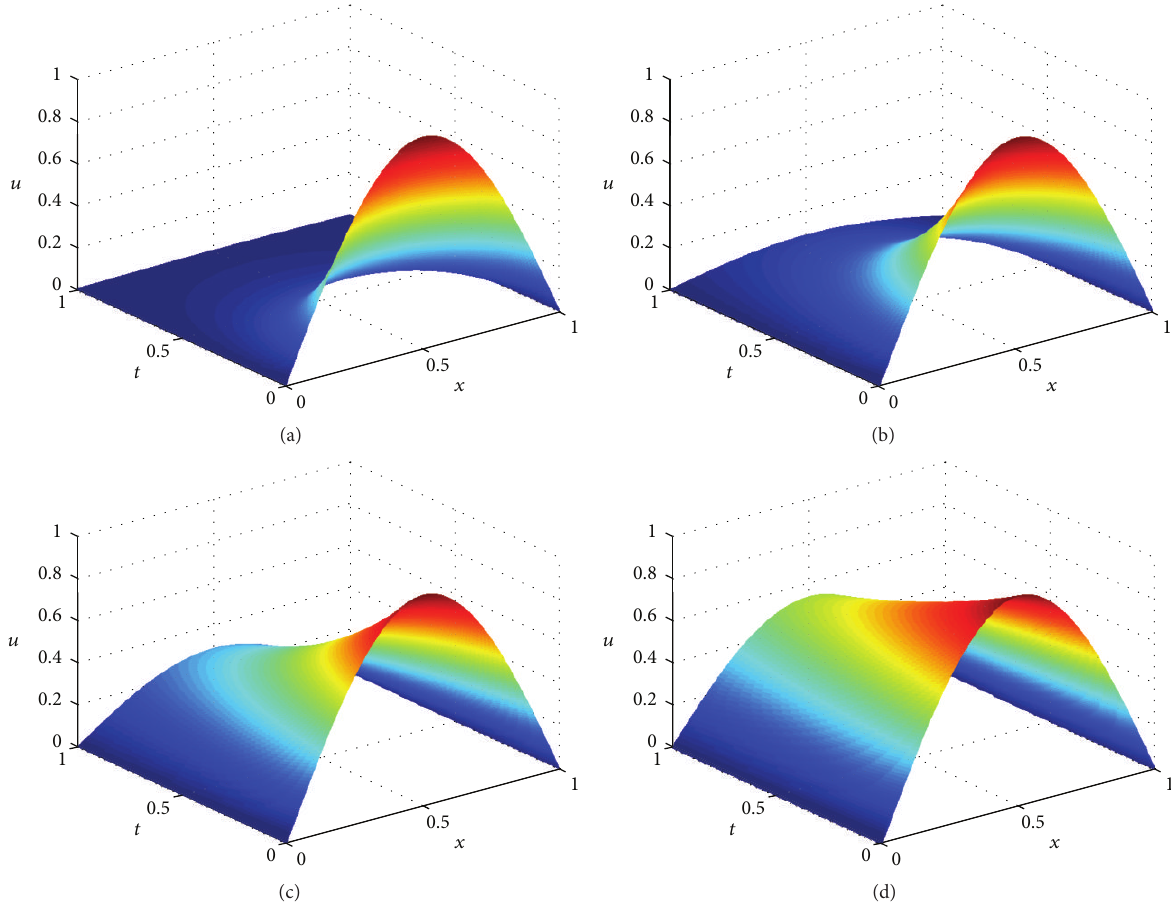
Figure 1: Permanence and existence of one-dimensional model (32) with Dirichlet boundary conditions at 𝑡 = 1